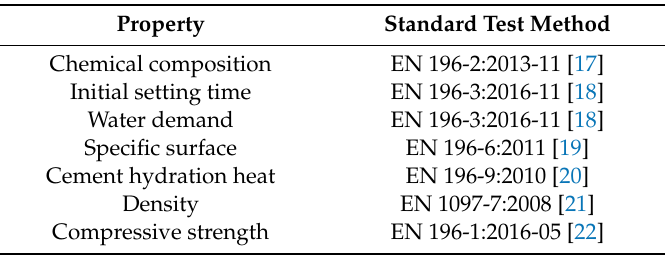
Table 1. Procedures applied to determine the properties of cement and main cement